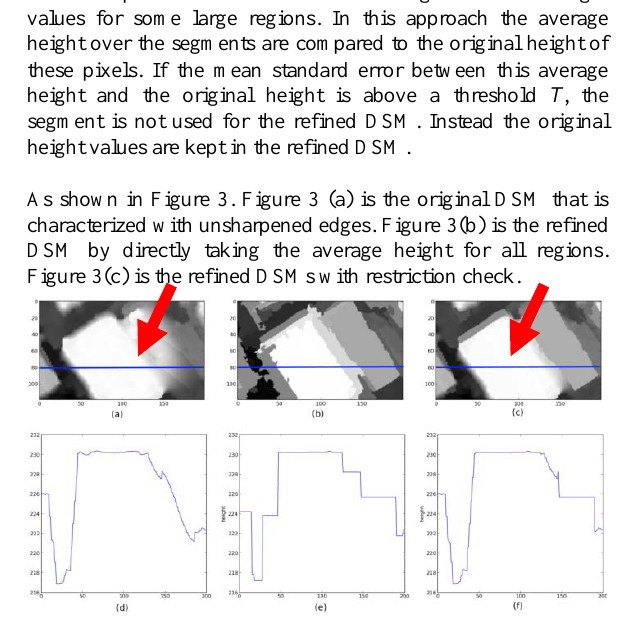
Figure 3. (a) Original DSM. (b) Refined DSM with average over boundaries. (c) Refined DSM result. (d,e,f) Height profiles of a,b,c.